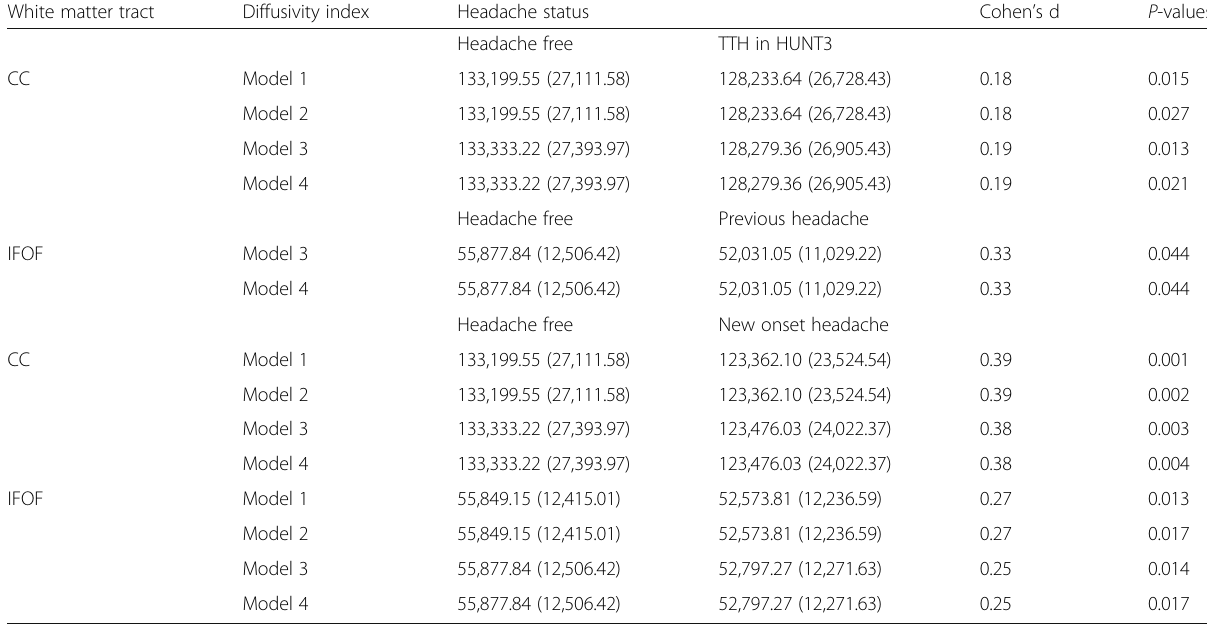
Model 1=Corrected for age, sex and ICV Model 2=Corrected for age, sex, ICV and WMH Model 3=Corrected for age, sex, ICV, HADS, chronic pain and consumption of alcohol and over-the-counter painkillers Model 4=Corrected for age, sex, ICV, WMH, HADS, chronic pain and consumption of alcohol and over-the-counter